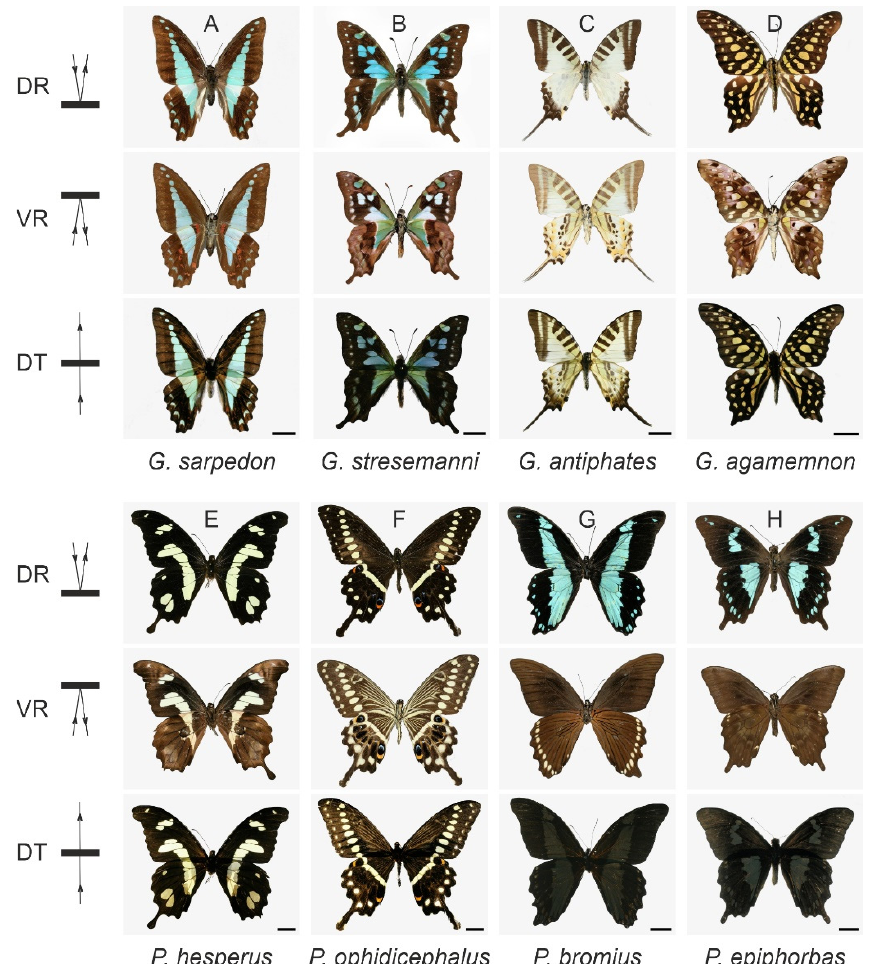
Figure 4. Wing patterning and translucence of papilionid butterfly wings: ( A ) Graphium sarpedon Linnaeus, 1758; ( B ) Graphium stresemanni Linnaeus, 1758; ( C ) Graphium antiphates Cramer, 1775; ( D ) Graphium agamemnon Linnaeus, 1758; ( E ) Papilio hesperus Westwood, 1843; ( F ) Papilio ophidicephalus Oberthür, 1878; ( G ) Papilio bromius Doubleday, 1845; ( H ) Papilio epiphorbas Boisduval, 1833. DR—dorsal reflection; VR—ventral reflection; DT—dorsal transmission; scale bars: 1 cm.